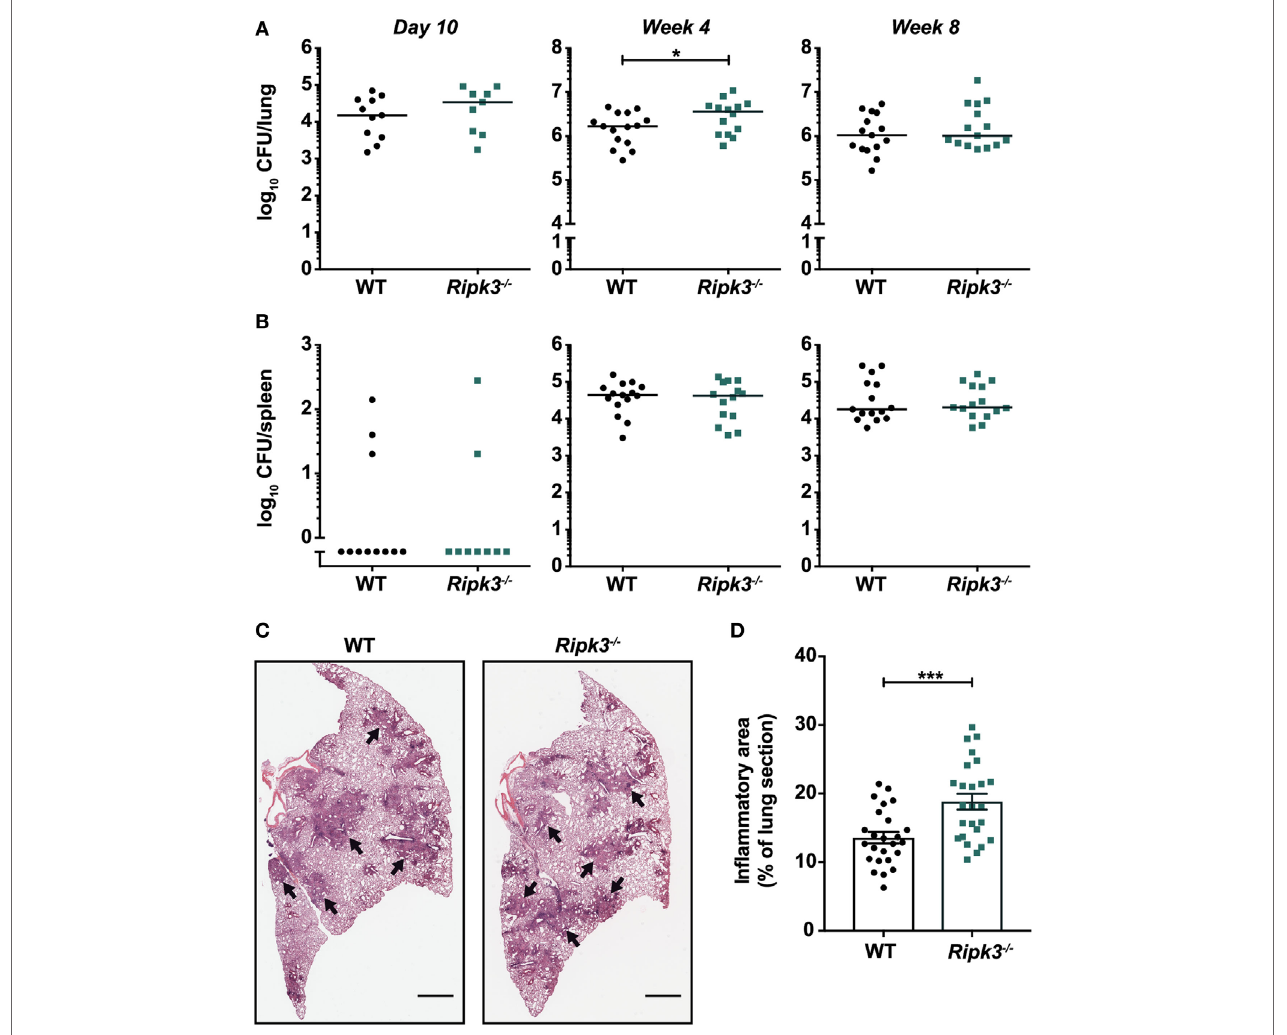
FigUre 2 | Impact of receptor-interacting protein kinase 3 deficiency on Mycobacterium tuberculosis (Mtb) disease pathogenesis in mice. Bacterial burden in the (a) lungs and (B) spleens of mice at various time points post-infection with aerosolized Mtb. Data were pooled from two (day 10 and week 8) or three (week 4) independent experiments ( n = 9–15 per time point and genotype). (c) Lung histology of mice 4 weeks post-infection. Black arrows indicate examples of inflammatory areas. Left lobes were stained with hematoxylin and eosin. Representative of 25 mice per genotype. Scale bar represents 1 mm. (D) Quantitation of inflammatory areas in H&E-stained lung sections of mice 4 weeks post-infection. Data were pooled from five independent experiments ( n = 25 per genotype). Graphs show median (a,B) or mean ± SEM (D) and each point represents one mouse. There were no statistically significant differences between genotypes ( p > 0.05) unless indicated. * p < 0.05; *** p <